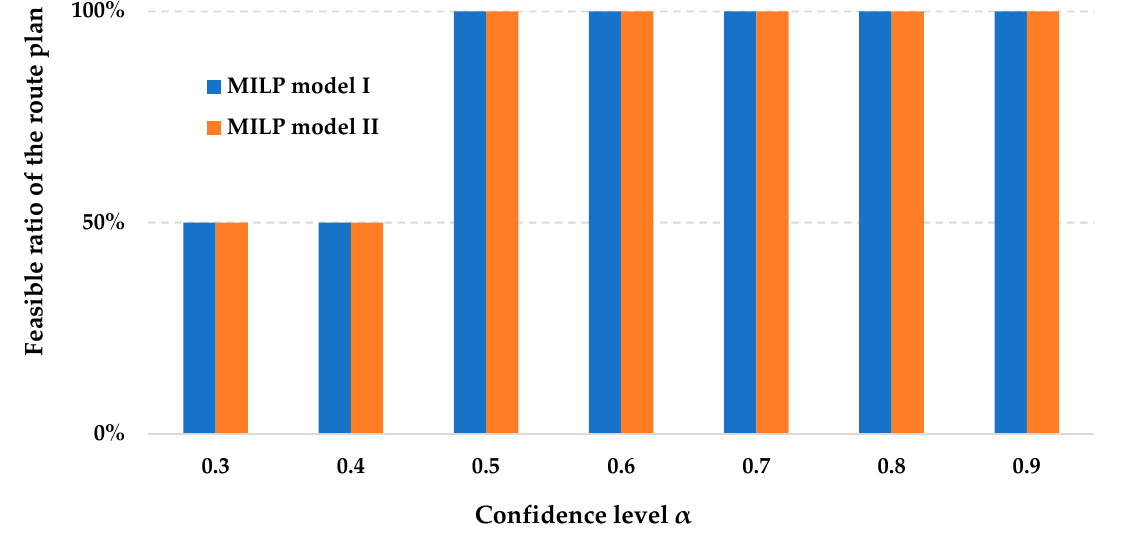
Figure 16. Feasible ratio of the route plans provided by the fuzzy programming models under different confidence levels in the 10 deterministic cases.